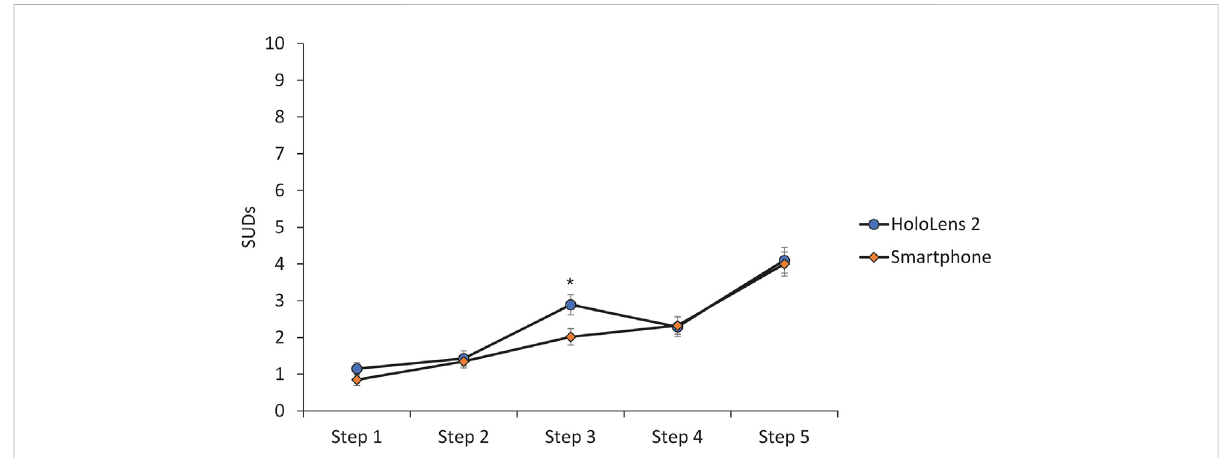
FIGURE 2 Self-reportedsubjectiveUnitsofDistress(SUDs)ateachofthe fi vestepsoftheBATinbothconditions(errorbarsrepresentthestandarderrorof the mean). * marks a signi fi cant difference at p < 0.05 at step 3.